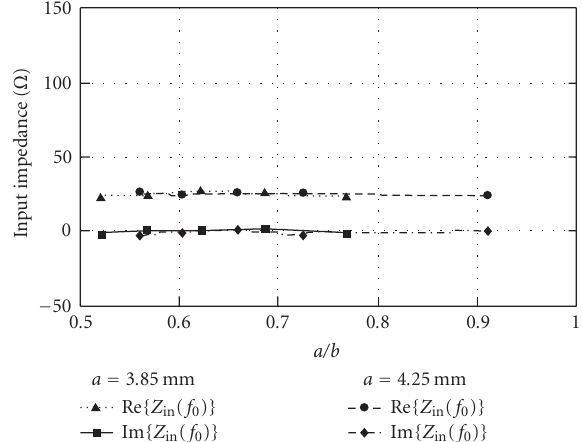
Figure 3: Real and imaginary values of the DRA input impedance at the fundamental frequency versus length-to-height ratio, for two values of the resonator length: a = 3 . 85 mm and a = 4 . 25mm.